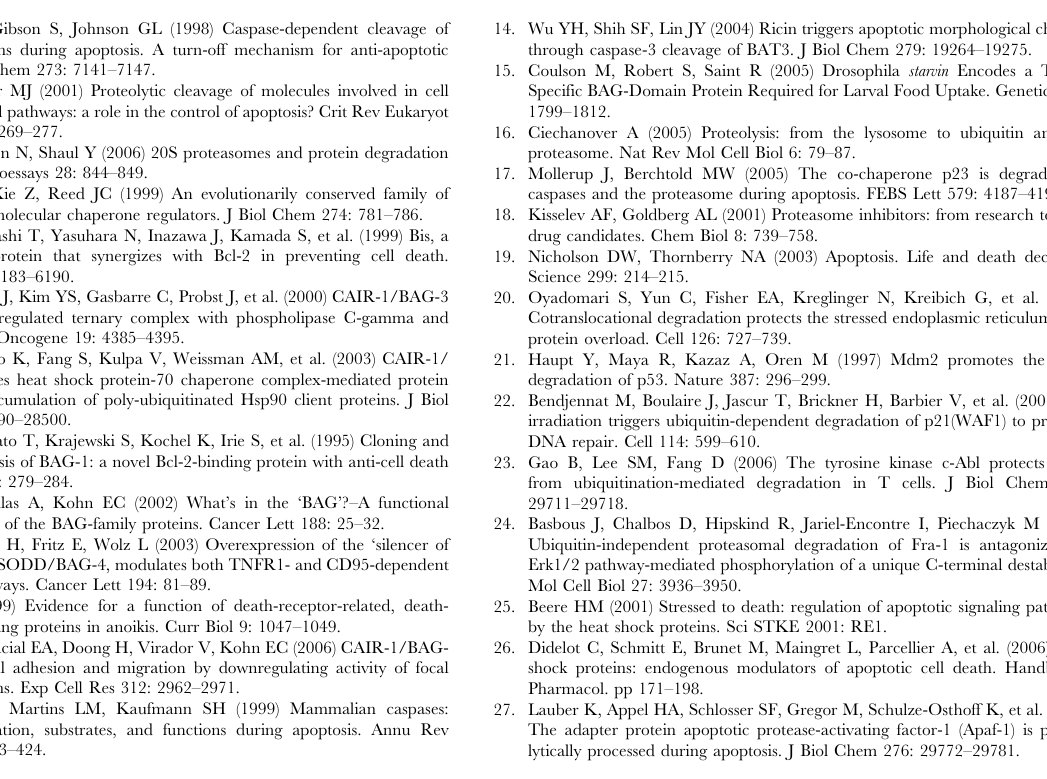
Figure S4 Disappearance of the BAG3 signal by siRNA. MDA435-Neo cells were exposed to 200 nM BAG3 siRNA or scramble control for 72 hours followed by addition of vehicle control or 2 m M STS for additional 6 hrs. Immunoblot demon- strates silencing of BAG3. Figure S5 Commonly used ‘housekeeping proteins’ are degrad- ed by STS in HeLa and MDA 435 cells. A. HeLa cells overexpressing BAG3. BAG3 signal disappears with increasing time of exposure to 2 m M STS. GAPDH (re-blot) likewise disappears with STS exposure. B. MDA435 cells. BAG3 signal disappears with STS and is protected by addition of MG-132 or MG-132 and zVAD in combination. The signal for b -tubulin (re- blot) diminishes with STS